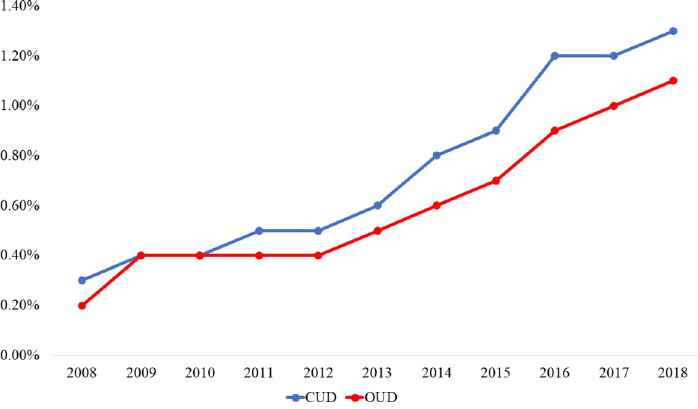
Fig 1. Percent of HF admissions with CUD and OUD over time: Primary HF admissions with a co-diagnosis of CUD or OUD were trended over 2008 to 2018 and then linear regression was used to analyze significance of trends. Linear regression: p < 0.001,